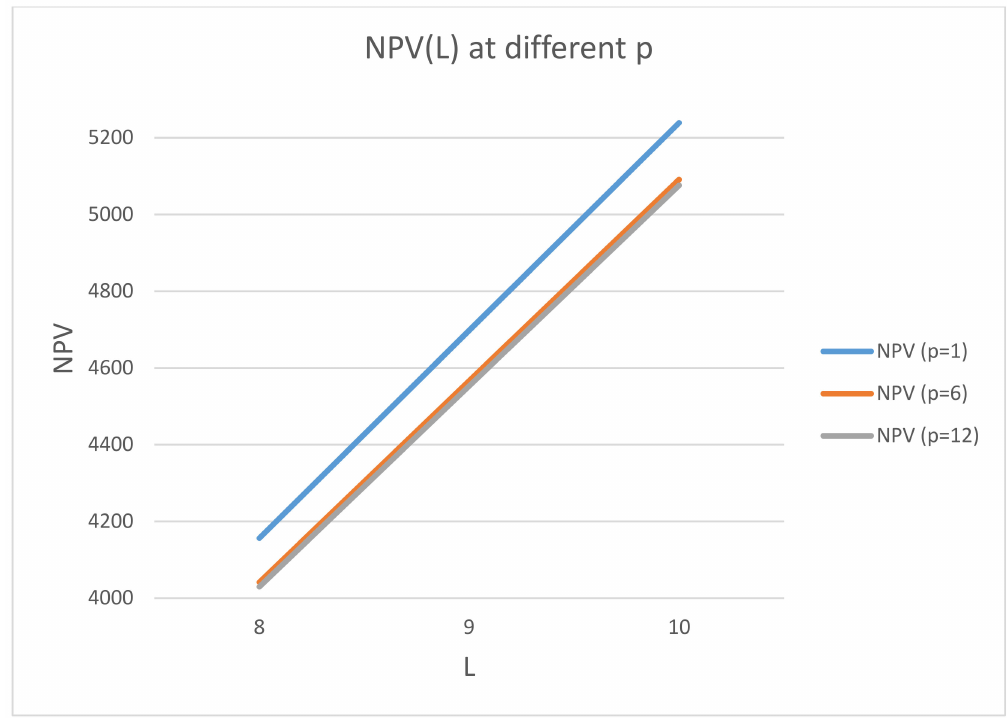
Figure 9. Dependence of NPV on leverage level L at k 0 = 0.22, k d = 0.14 and different p = 1, 6, 12 for a three-year project (larger scale).